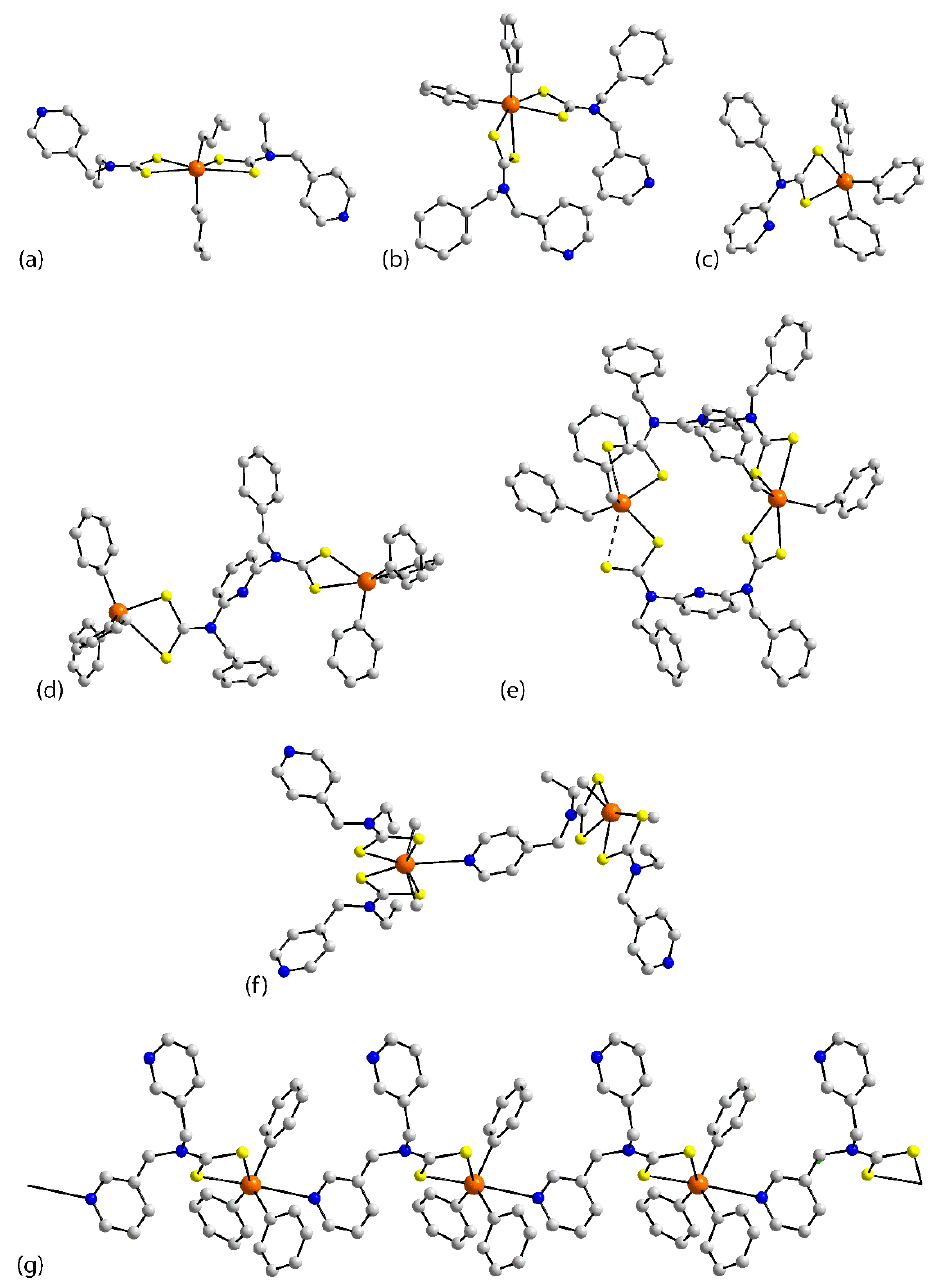
Figure 20. Molecular structures of ( a ) (nBu) 2 Sn(L 14 ) 2 ( 62 ), ( b ) Ph 2 Sn(L 1 ) 2 ( 63 ) and ( c ) Ph 3 Sn(L 27 ) ( 65 ), ( d ) the open dimer in (Ph 3 Sn) 2 (L 28 ) ( 66 ), ( e ) the cyclic dimer in the crystal of [(PhCH 2 ) 2 Sn)(L 28 )] 2 ( 67 ), ( f ) the dimer in the crystal of [Me 2 Sn(L 14 ) 2 ] 2 ( 68 ), and ( g ) the one-dimensional chain in [Ph 3 Sn(L 11 )] n ( 69 ).